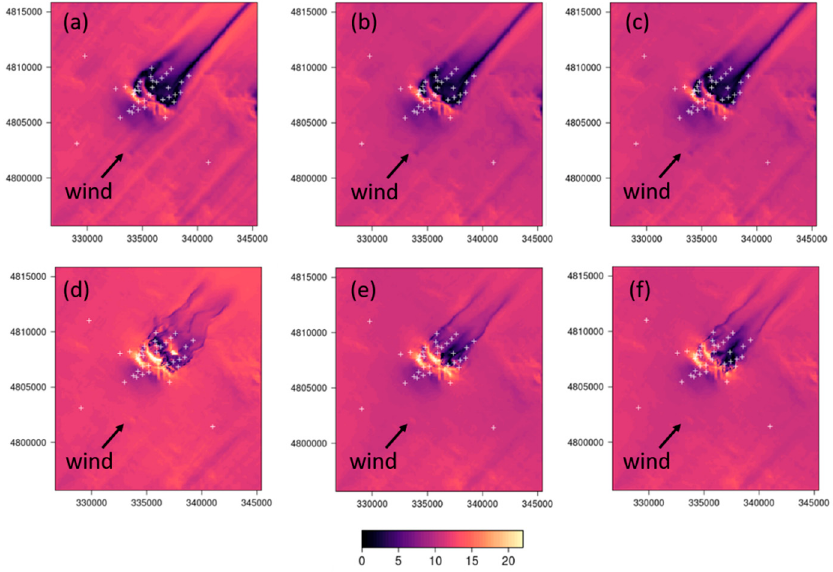
White crosses indicate measurement locations. Black arrows denote the prevailing wind direction. Axes labels are in meters.